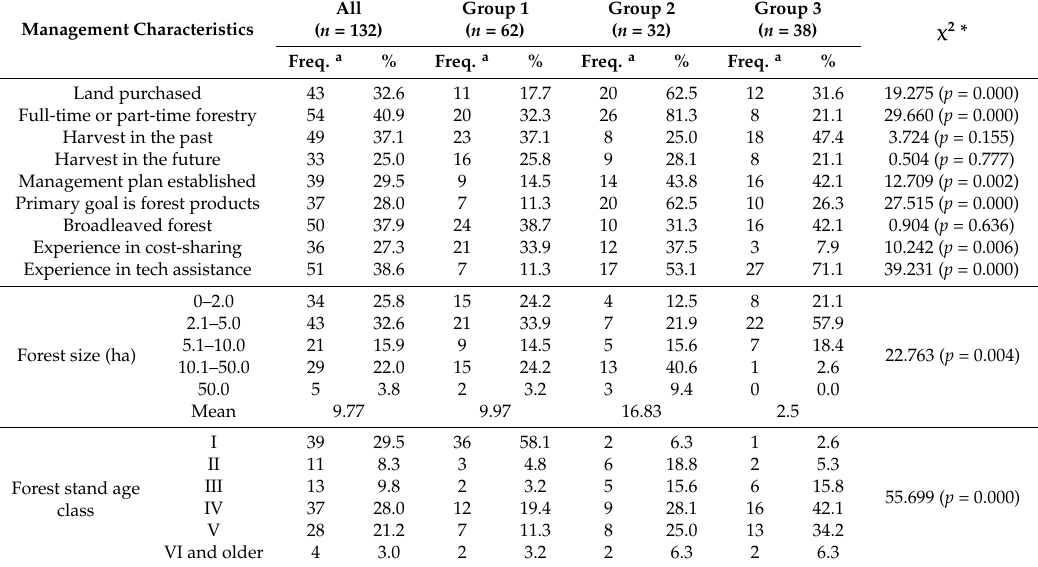
Table 4. Forest management characteristics of survey